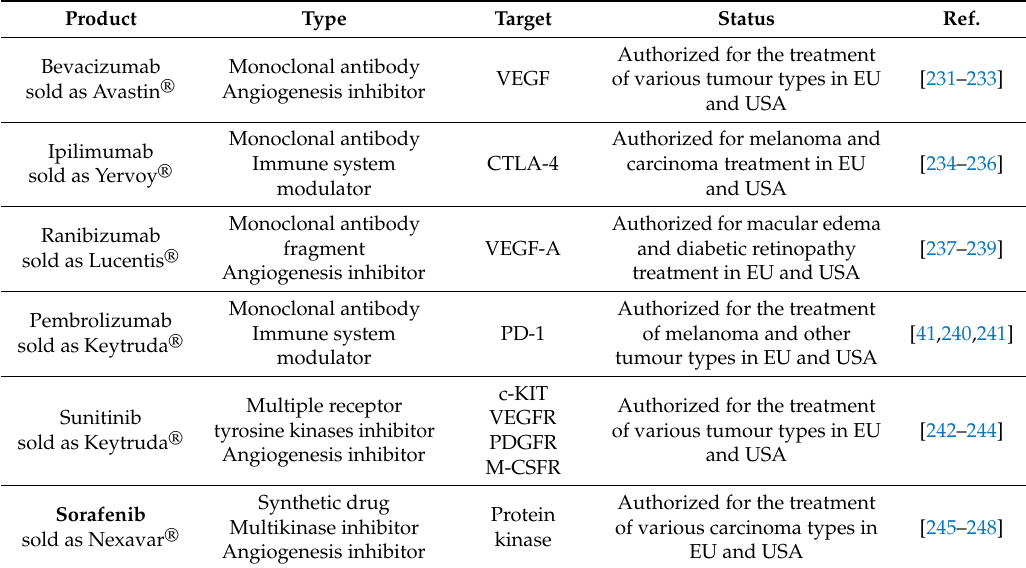
Table 2. Examples of drugs under study for the treatment of uveal melanoma or uveal melanoma-related conditions that are already approved for the treatment of other oncological